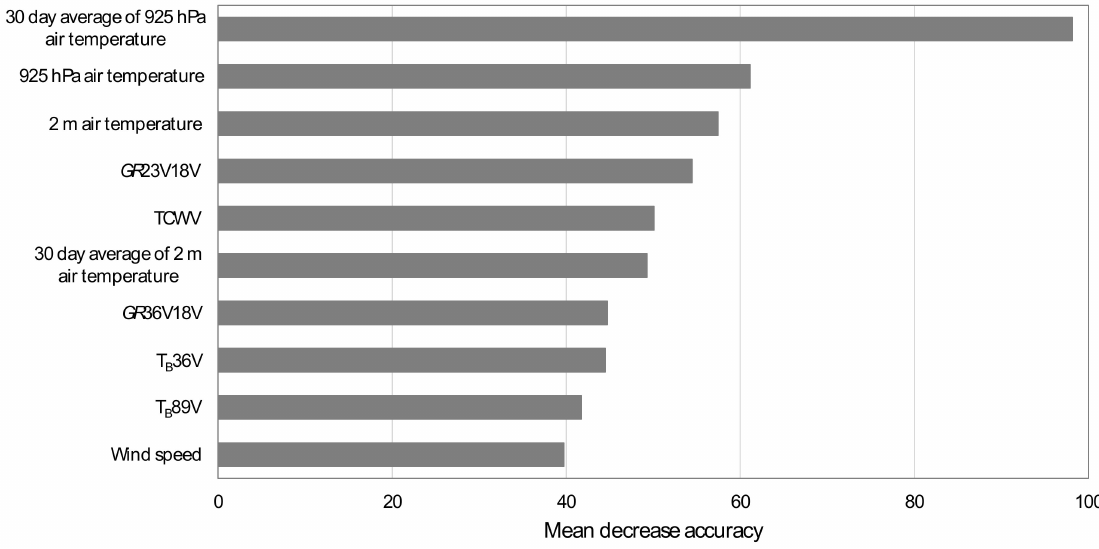
Figure 9. Mean decrease in accuracy of the RF